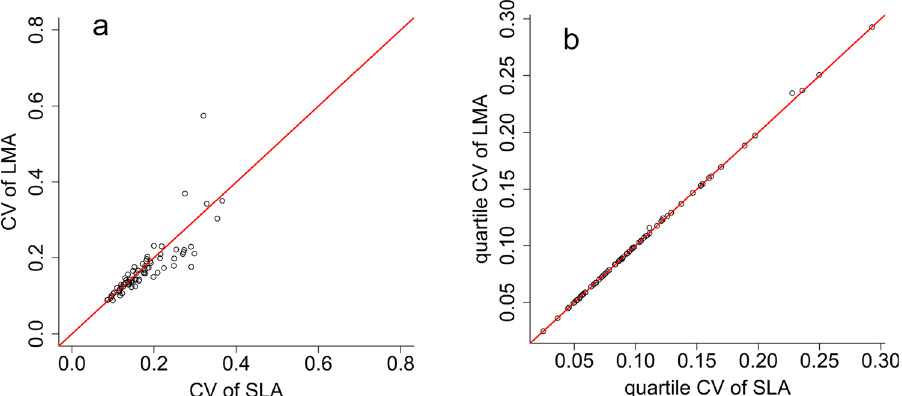
Figure 1. Within-species relative variation of specific leaf area (SLA) and leaf mass per area (LMA) calculated by ( a ) CV (coefficient of variation, standard deviation divided by mean) and ( b ) quartile coefficient of variation (see formula in the main text). Red line is the 1:1 line.